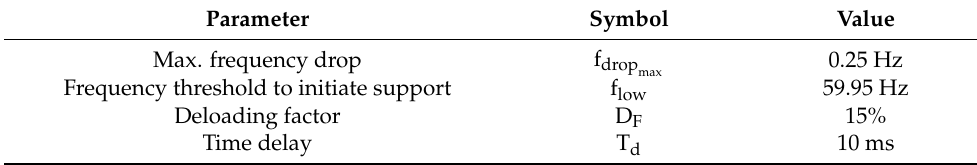
Table 2. The values of the parameters of the implemented pitch deloading control.